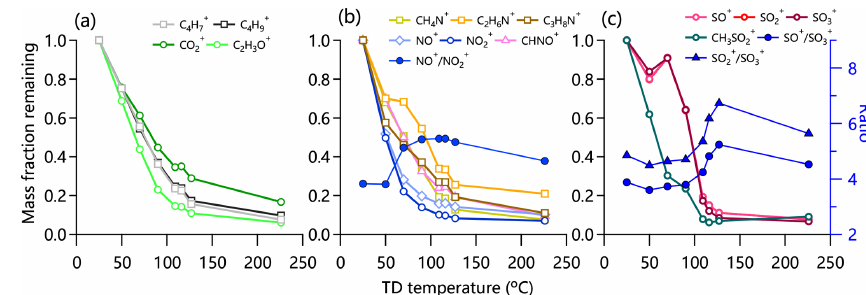
Figure 3. Thermograms of (a) C 4 H + (c) SO + , SO + and (c) .